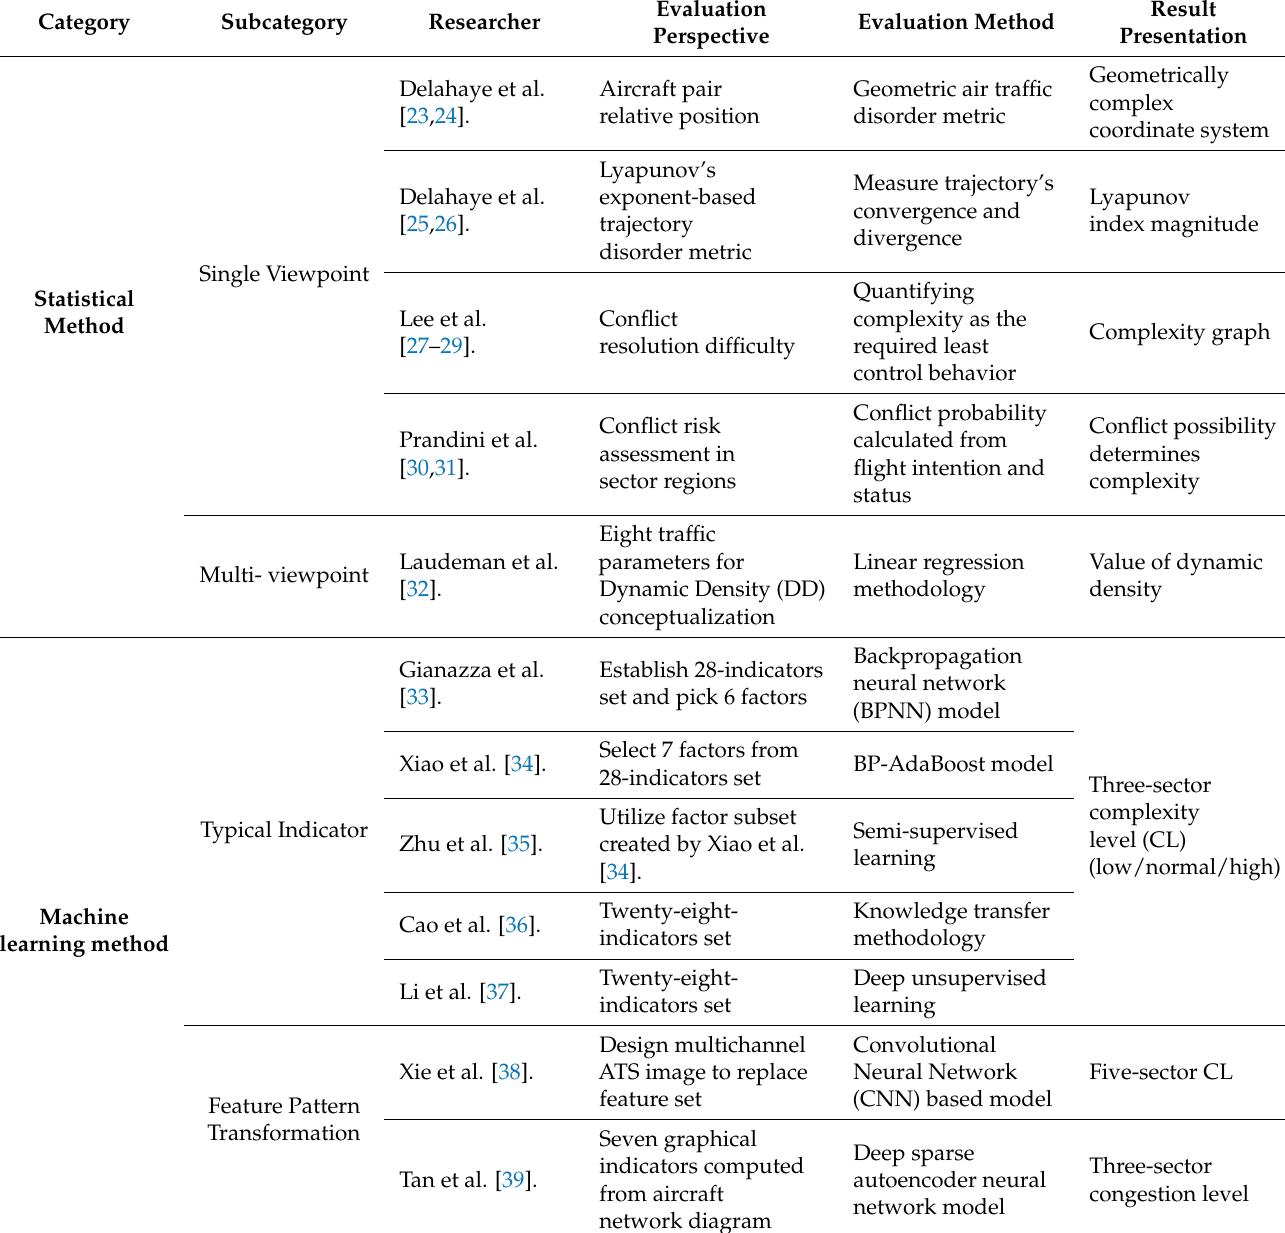
Table 1. Studies representative of evaluating air traffic